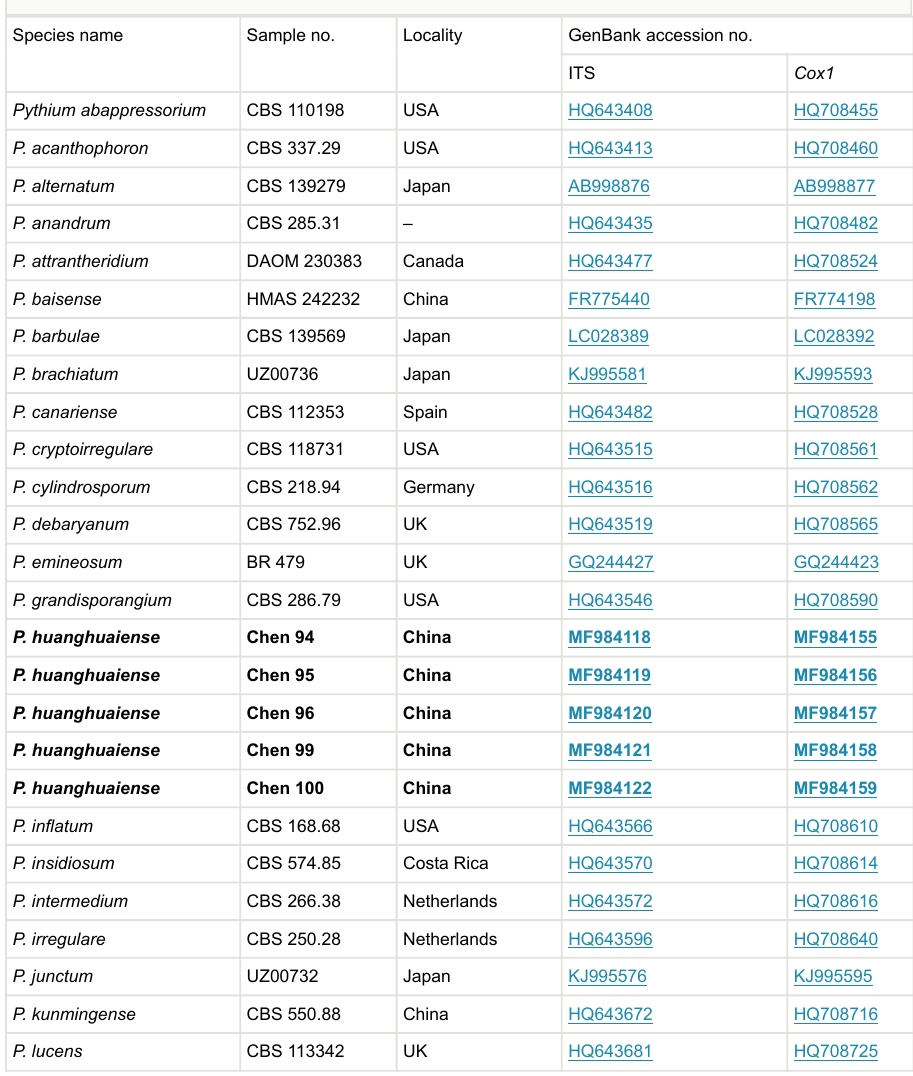
10 min (Rahman et al. 2014). PCR products were purified and sequenced by Genscript (Nanjing, China) using the same primers. Sequences, generated in this study, were aligned with additional sequences downloaded